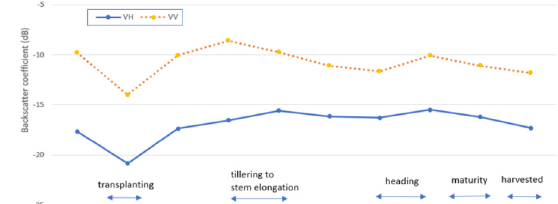
Fig.6: Backscatter dynamic of the rice plot at the VH and VV polarizations